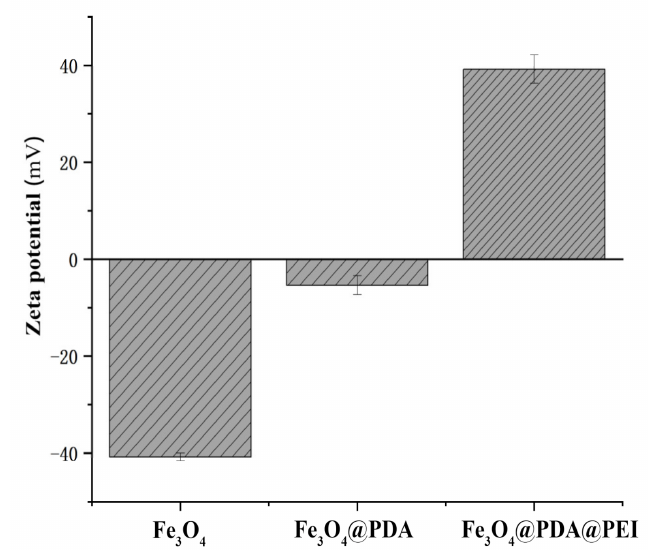
Figure 5. Zeta potential changes. (pH = 7.4, 25 ◦ C, 0.025